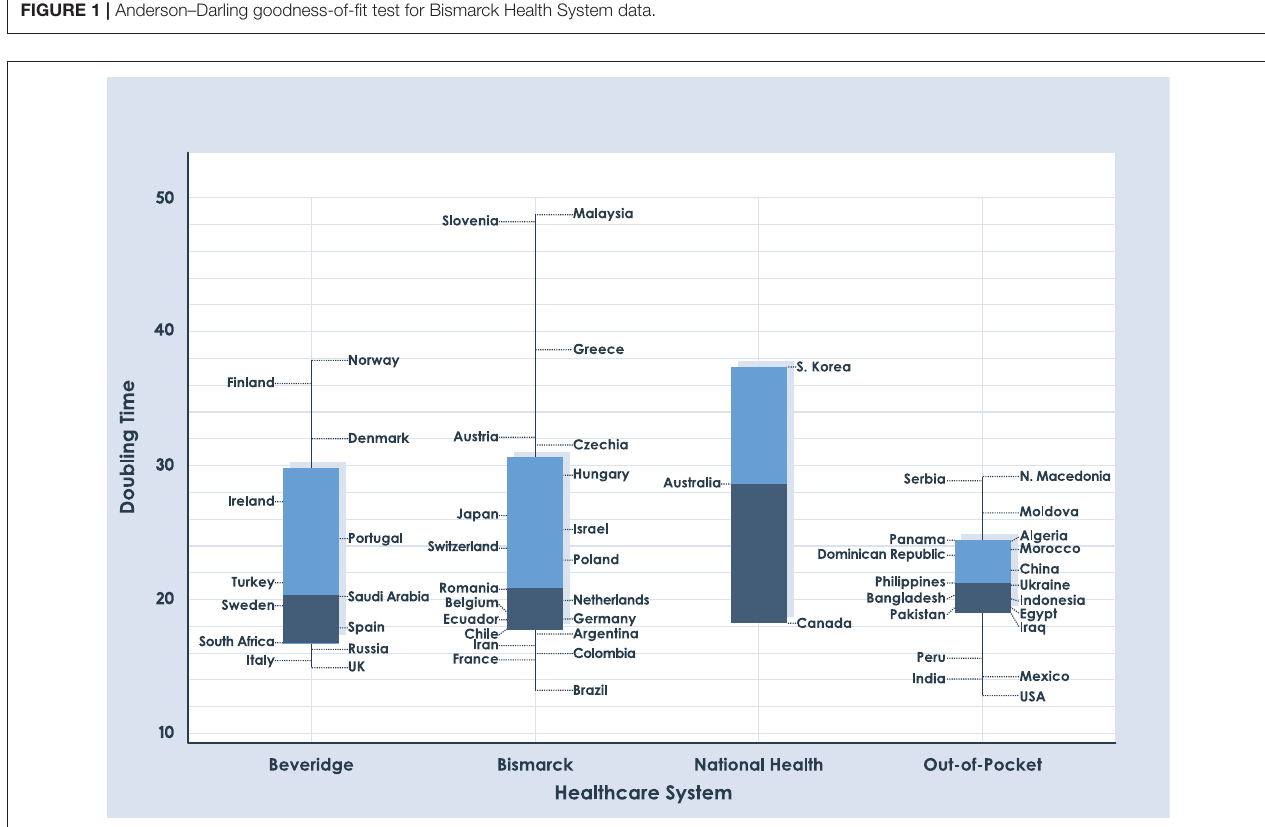
FIGURE 1 | Anderson–Darling goodness-of-fit test for Bismarck Health System data.